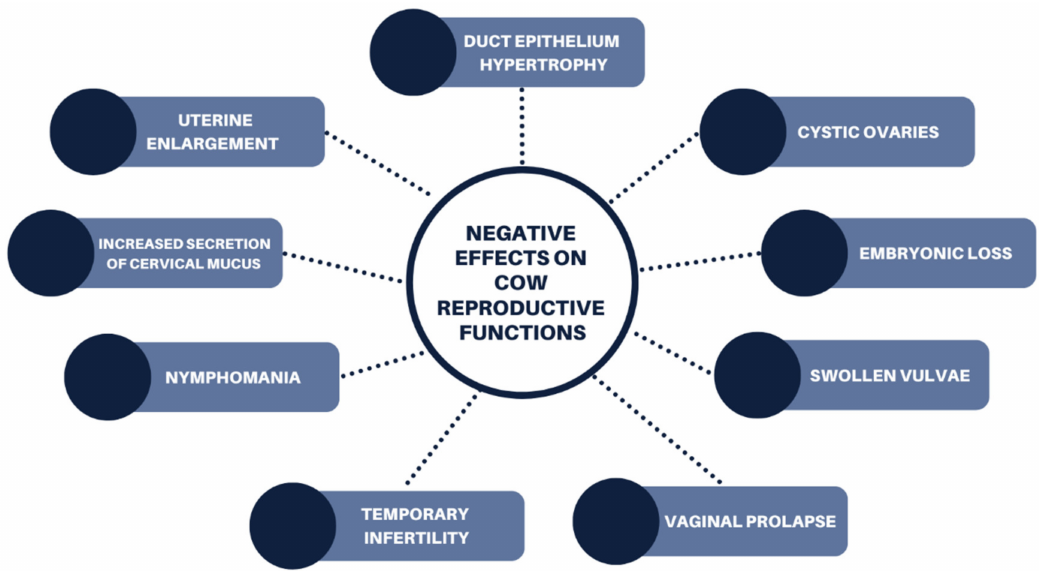
Figure 5. Negative effects of phytoestrogens on cow reproductive functions following ingestion of legume pasture